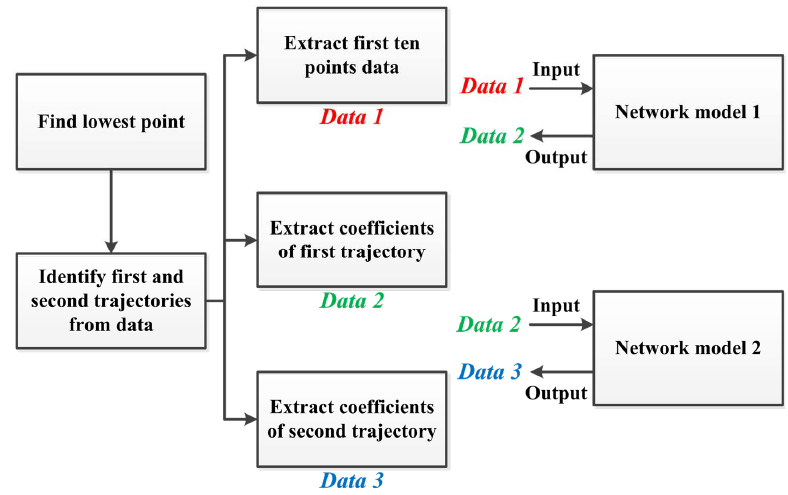
Figure 14. Procedure of generating the required training data.